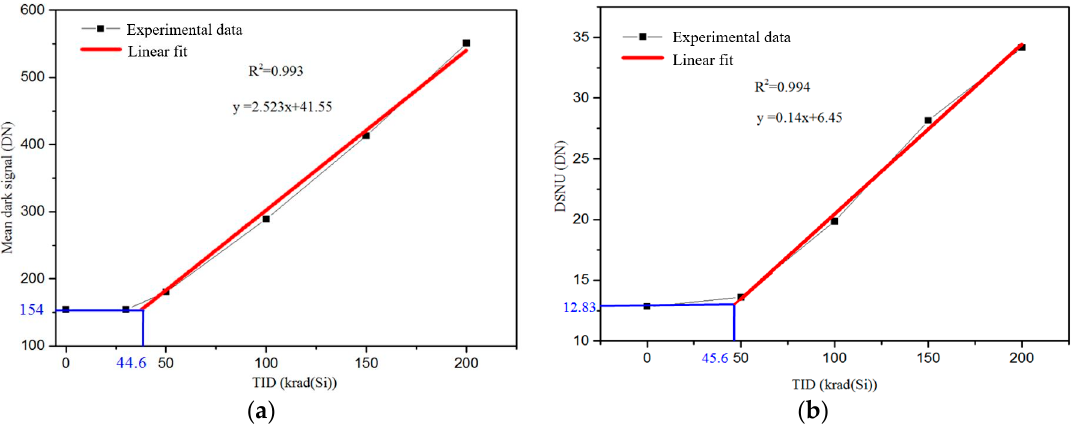
Figure 9. Mean dark signal and DSNU of CIS verse TID: ( a ) mean dark signal; and ( b ) DSNU.